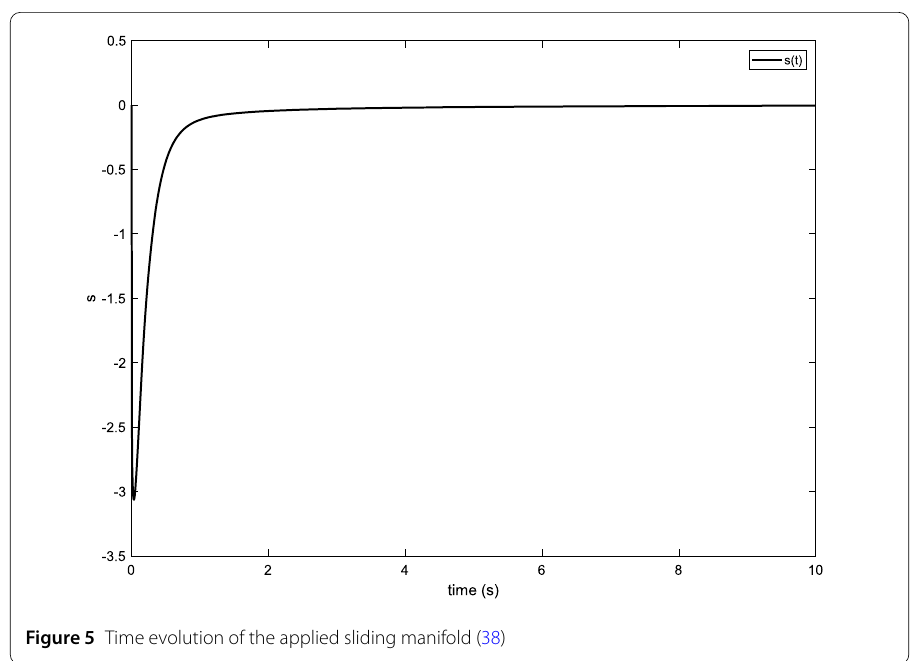
Figure 5 Time evolution of the applied sliding manifold (38)